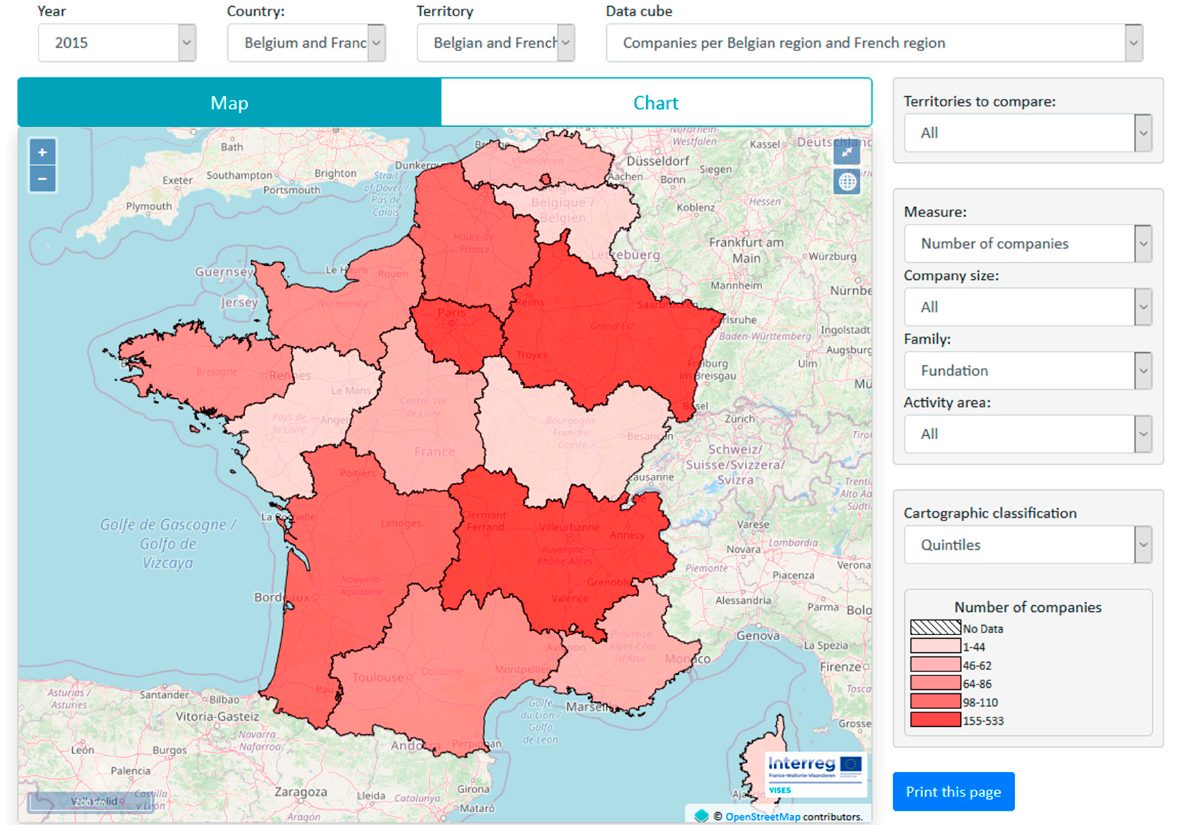
Figure 18. Racines module for spatial online analytical processing